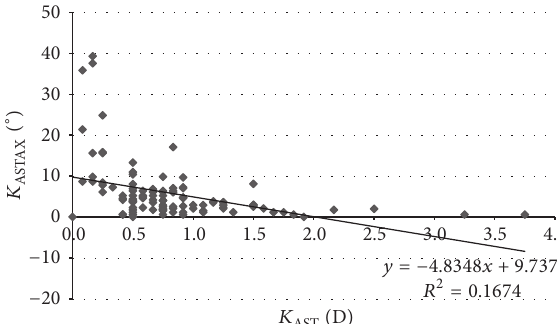
Figure 2: Scatterplot showing the relationship among the mean magnitude of keratometric corneal astigmatism ( 𝐾 AST ) and the within-subject standard deviation ( 𝑆 𝑤 ) associated with the axis of such corneal astigmatism ( 𝐾 ASTAX ). The adjusting line of data obtained by means of the least-squares fit is